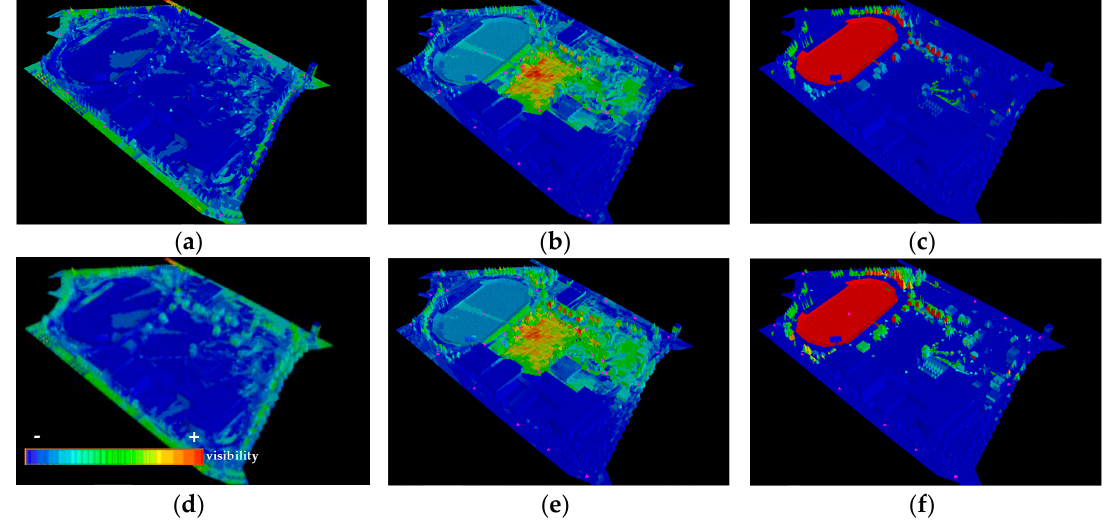
Figure 5. Visual connectivity maps of the effects on visibility of opacity in trees throughout the year, trees at 60% growth. ( a ) From the exterior of the park in summer; ( b ) from the interior of the park in summer; ( c ) isovist from inside the municipal field in summer; ( d ) from the exterior of the park in winter; ( e ) from the interior of the park in winter; ( f ) isovist from inside the municipal field in winter.